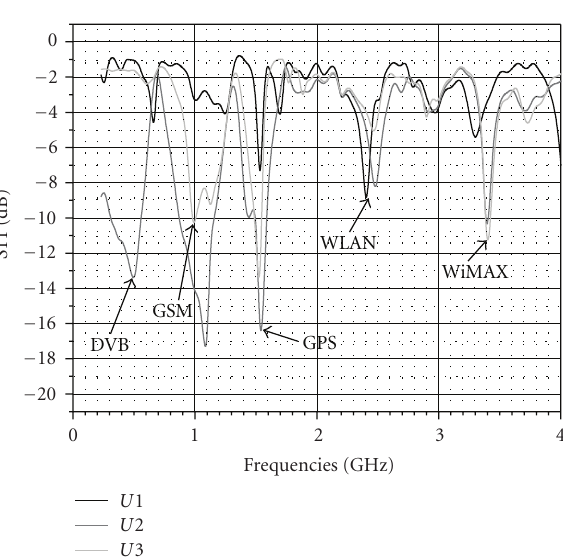
Figure 11: Return loss measuremen U 1 = 0 . 0 V, U 2 = 0 . 65 V, U 3 = 2 . 00 V are the PIN diode polarization voltages.